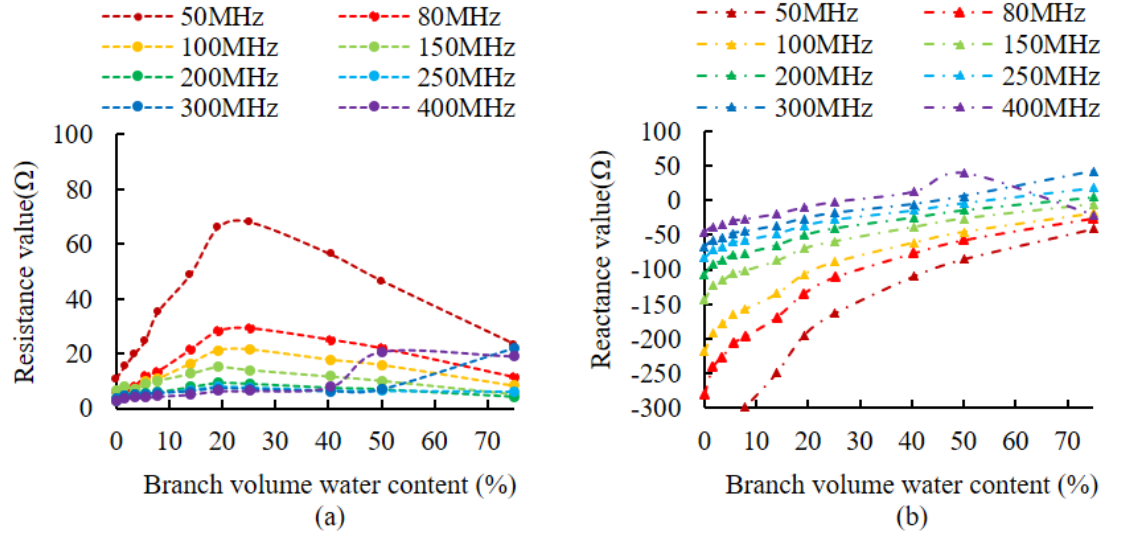
Figure 7. The variation of the impedance of the simulated branches. ( a ) The variation of the resistance component. ( b ) The variation of reactance components.